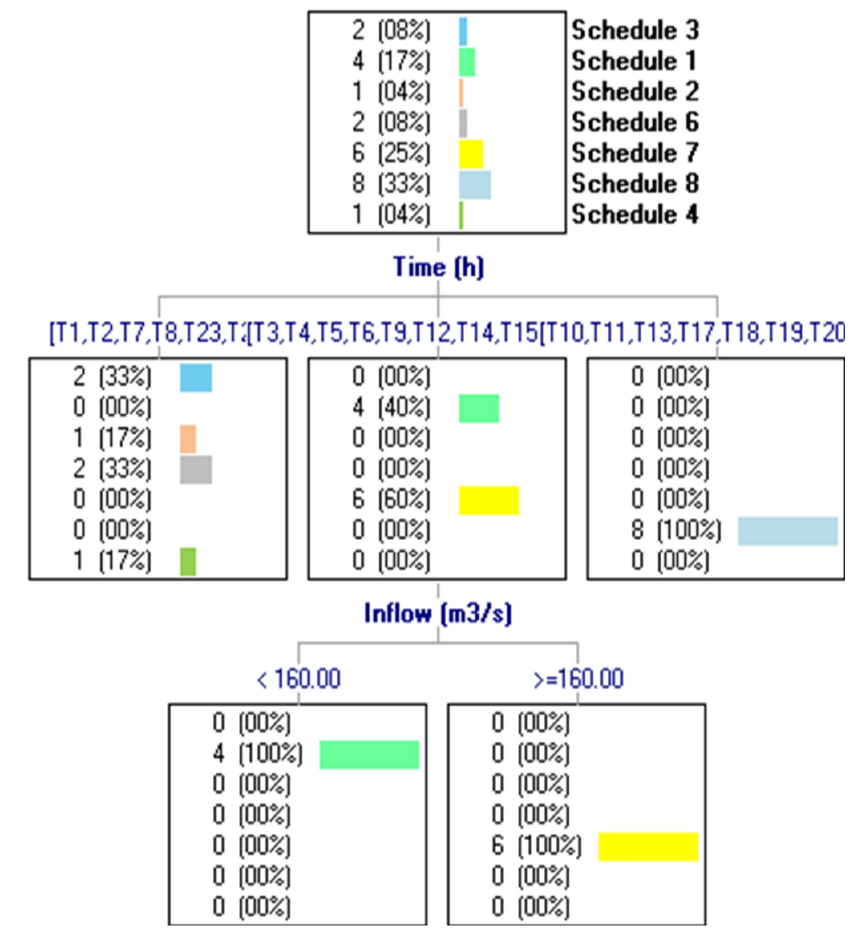
Figure 8. Decision tree of Tianshengqiao 2 plant generated by CHAID for the winter season.